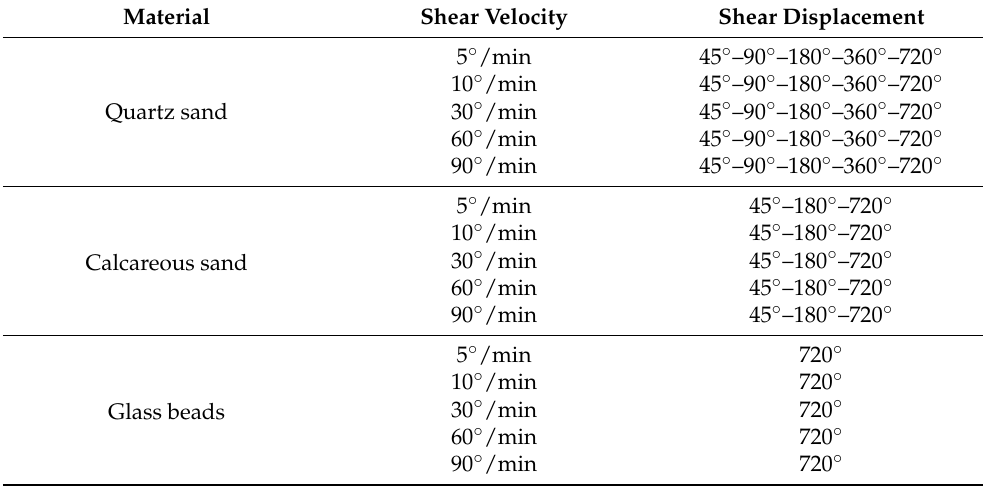
Figure 1. The basic condition of the ring-shear test. ( a ) Structure of GCTS ring-shear apparatus; ( b ) initial photos of experimental materials; ( c ) partition filling method. Table 1. Summary of ring-shear test conditions.